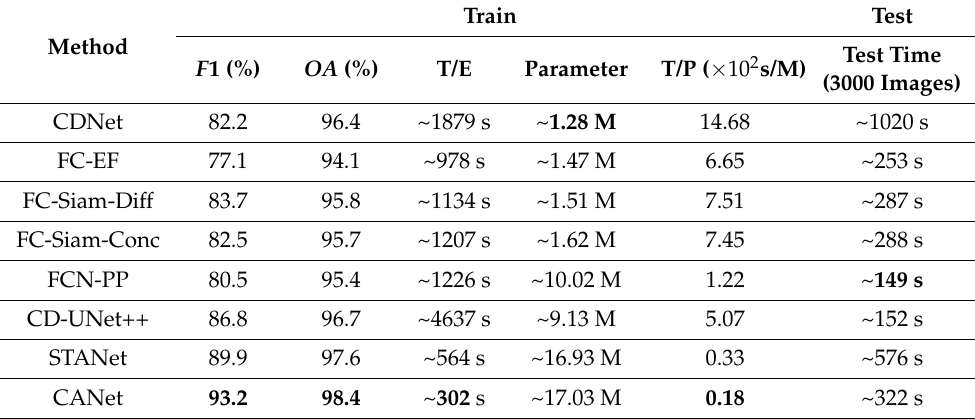
Table 5. Performance and speed trade-offs. (The best performance is emphasized in bold). Train Test Method